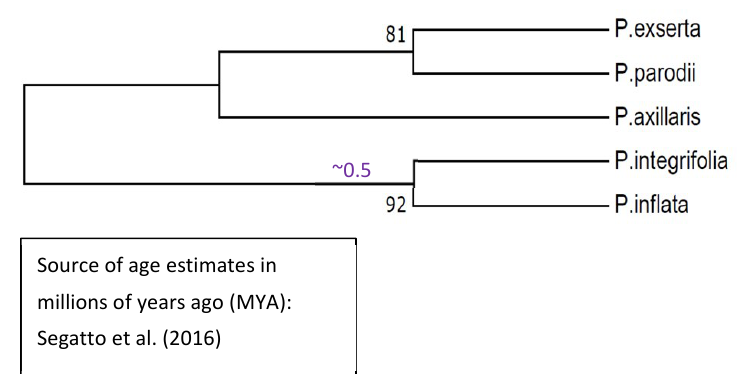
Figure 10. Phylogenetic reconstruction of HD-AGPs from five Petunia taxa. We used the UPGMA statistical method in the MEGA7 package with 1000 bootstrap replications. The genetic distances were computed using the Tamura-Nei model and are in the units of the number of base substitutions per site. The divergence time estimates, where available, are derived from Segatto et al.